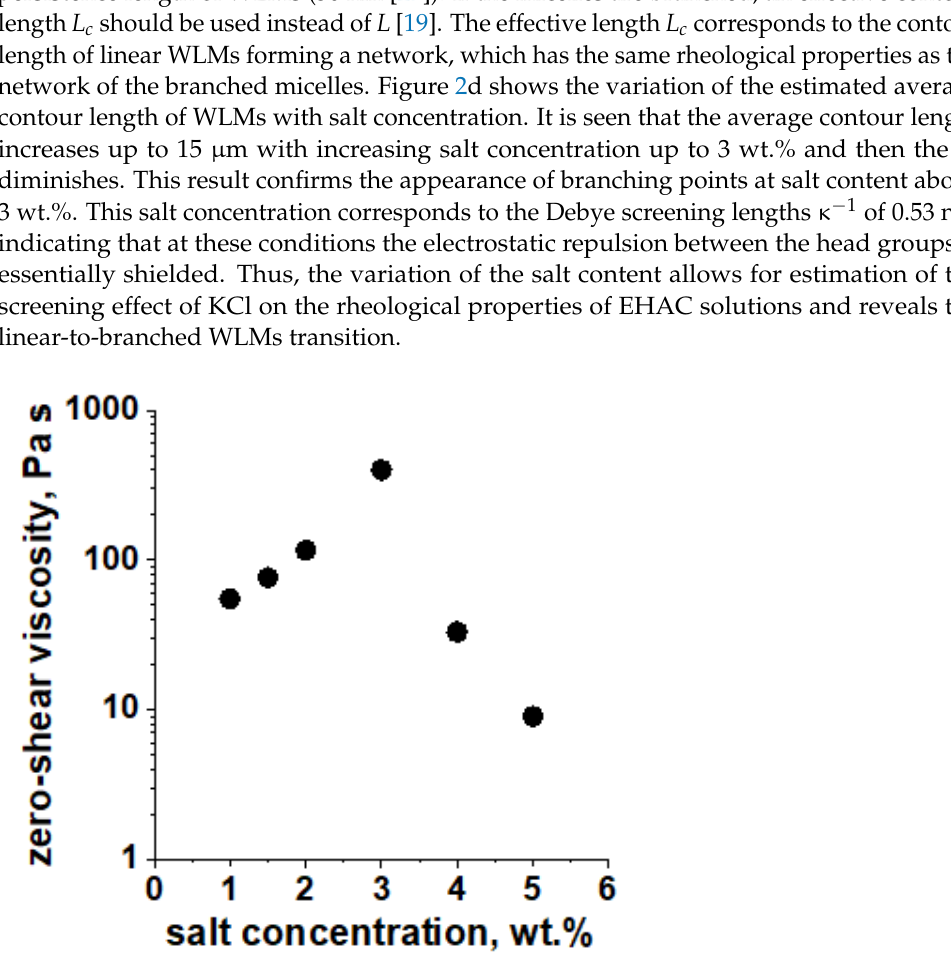
Figure 1. Zero-shear viscosity as a function of KCl concentration for 0.8 wt.% aqueous solutions of EHAC at 25 ◦